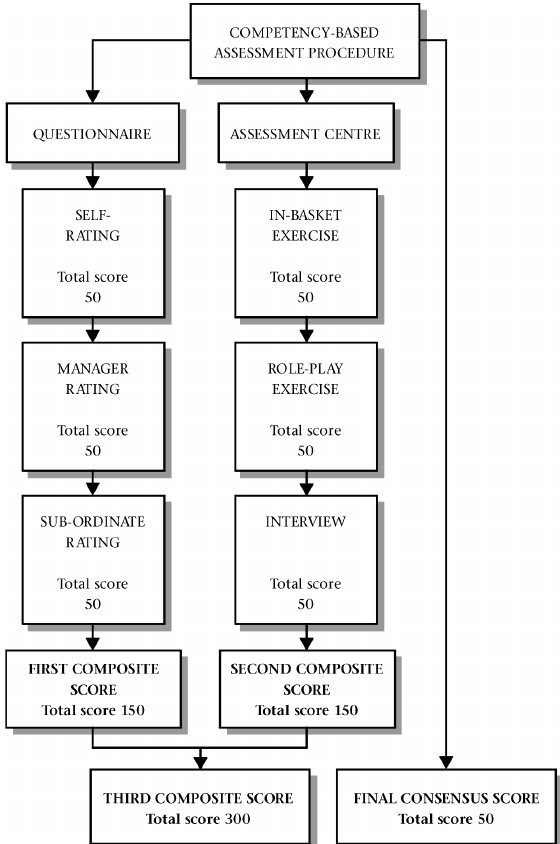
Figure 1: Competency-based, multi-dimensional,